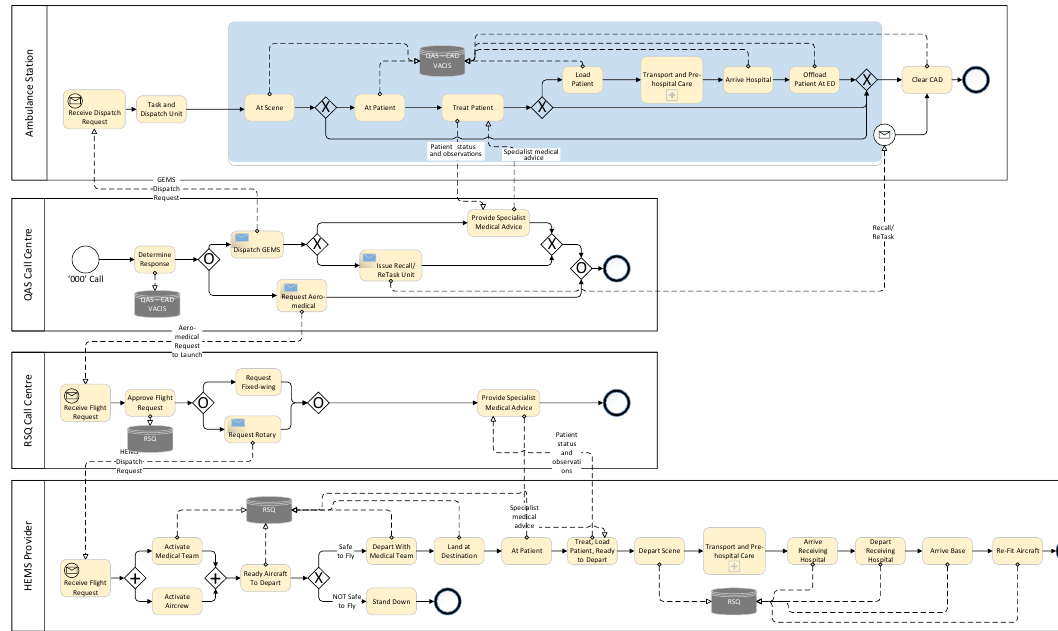
Figure 5. BPMN model of emergency incident management - ground and aero-medical call centre, asset deployment and patient